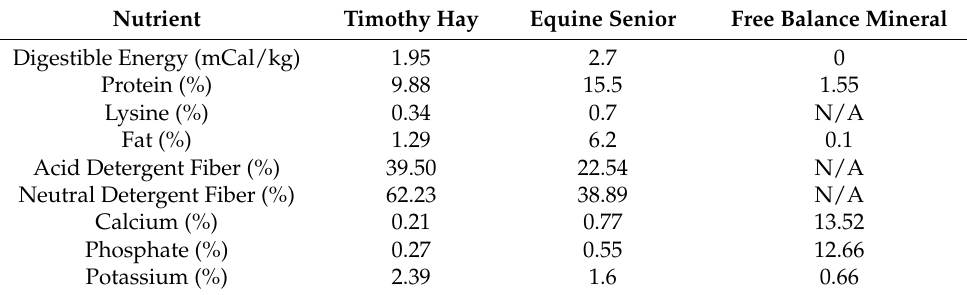
Table 2. Nutrient analysis of forage of diet components.